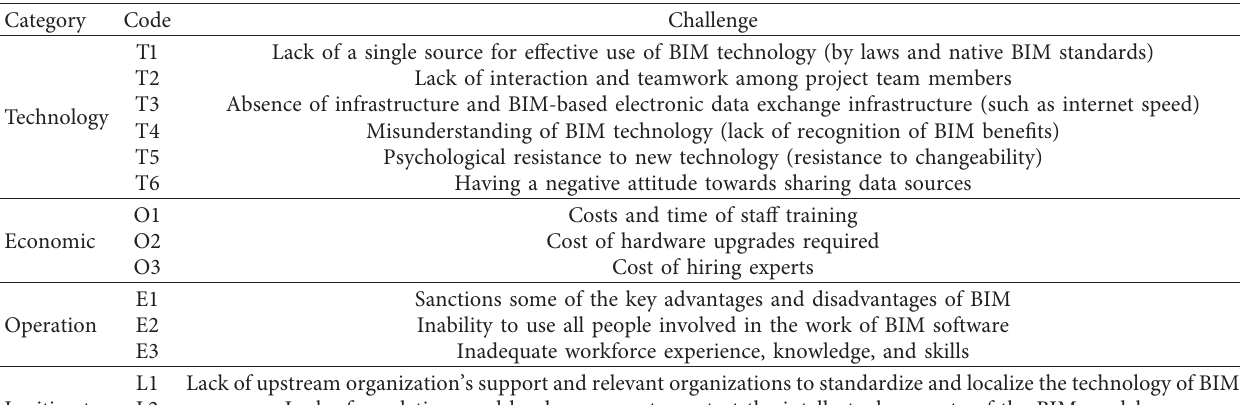
Table 2: Examined challenges of BIM